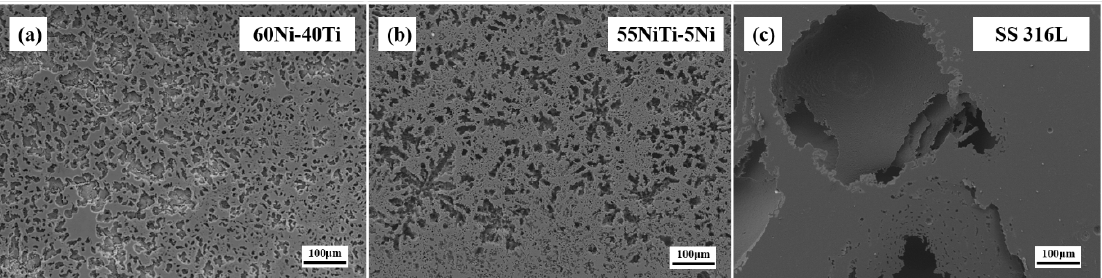
Figure 12. Corrosion morphology of coatings and substrate: ( a ) 60Ni-40Ti; ( b ) 55NiTi-5Ni; ( c ) SS 316L.